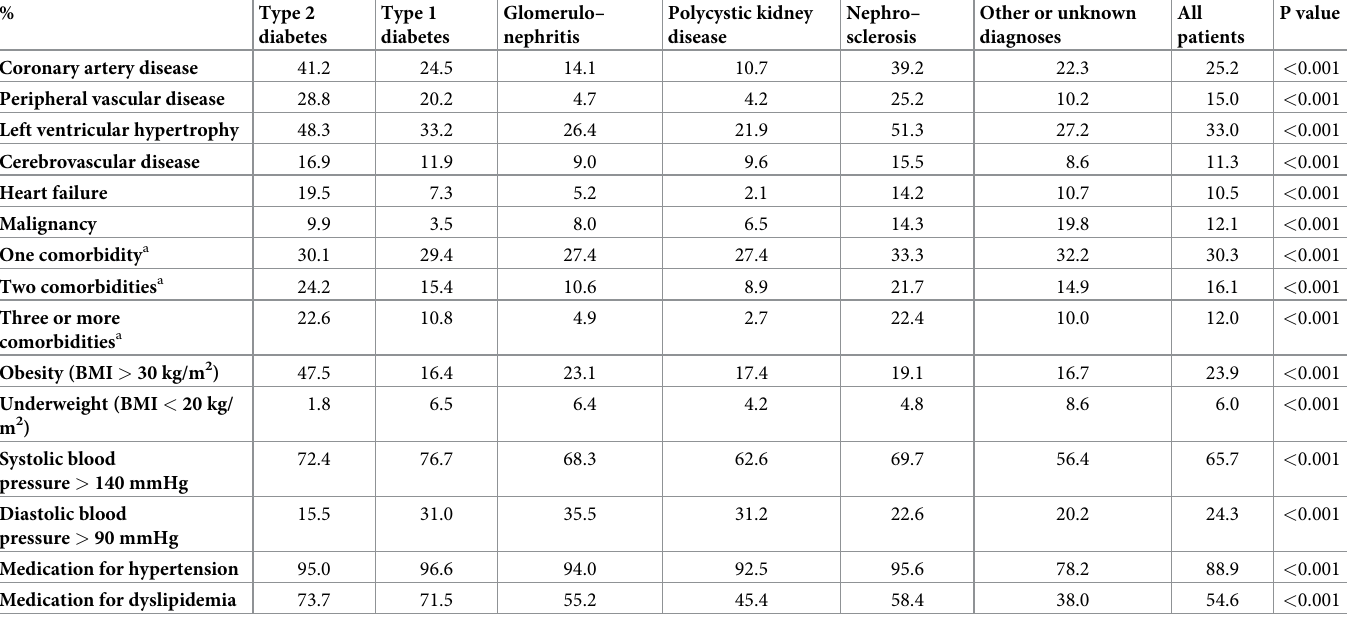
Table 2. Proportion of patients with comorbidities and medication at start of KRT according to primary kidney disease.